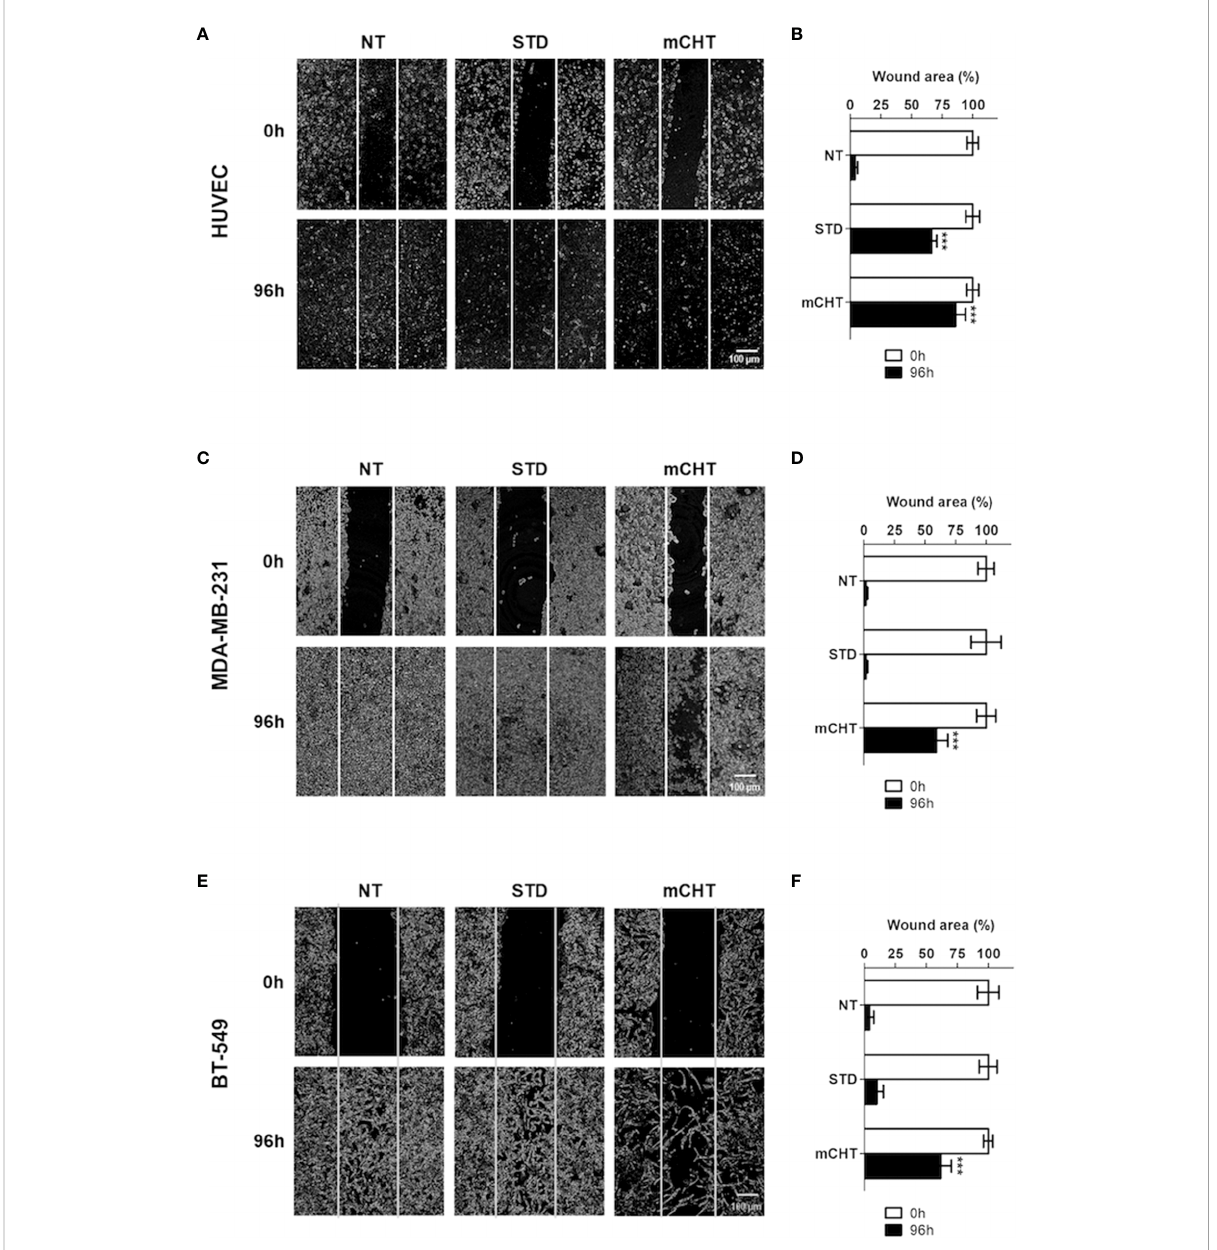
FIGURE 3 Metronomic administration of 5-FU+VNR is more ef fi cient than standard protocol in inhibiting wound closure of HUVECs and TNBC cells. Representative images of scratch tests performed on HUVECs (A) MDA-MB-231 cells (C) and BT-549 (E) before (0h) and 96h after STD or mCHT treatment with 5-FU+VNR. The area of the still open wound after 96h is quanti fi ed as a percentage of the initial scratch (B, D, F) . Values represent the average ± SD of three independent experiments. ***p <